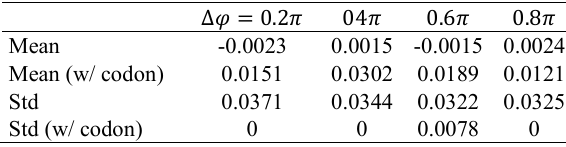
Table 2. Mean and Standard Deviation of Errors in Radians for Phase Offset